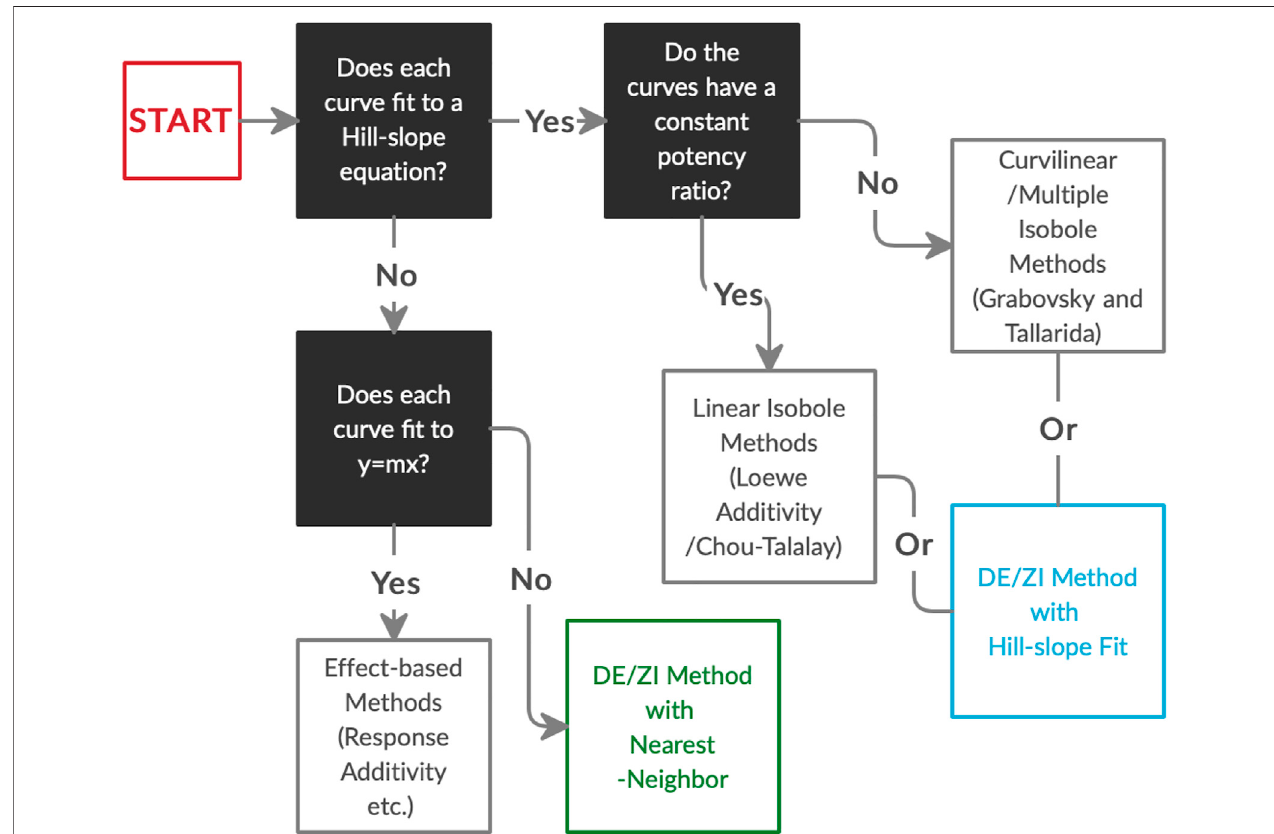
FIGURE 6 | The decision process in choosing an analysis method for drug-drug interactions based on the dosing curves of the compounds. DE/ZI, as an application of Loewe additivity principles, complements existing methods, and it meets a need for analysis of non-traditional dosing curves. Associated information on constant potency ratios and effect-based methods is given in Figure 1 and Loewe Additivity Principles Behind the DE/ZI Method and the Bene fi ts of Releasing the Constraint of a Constant Potency Ratio .